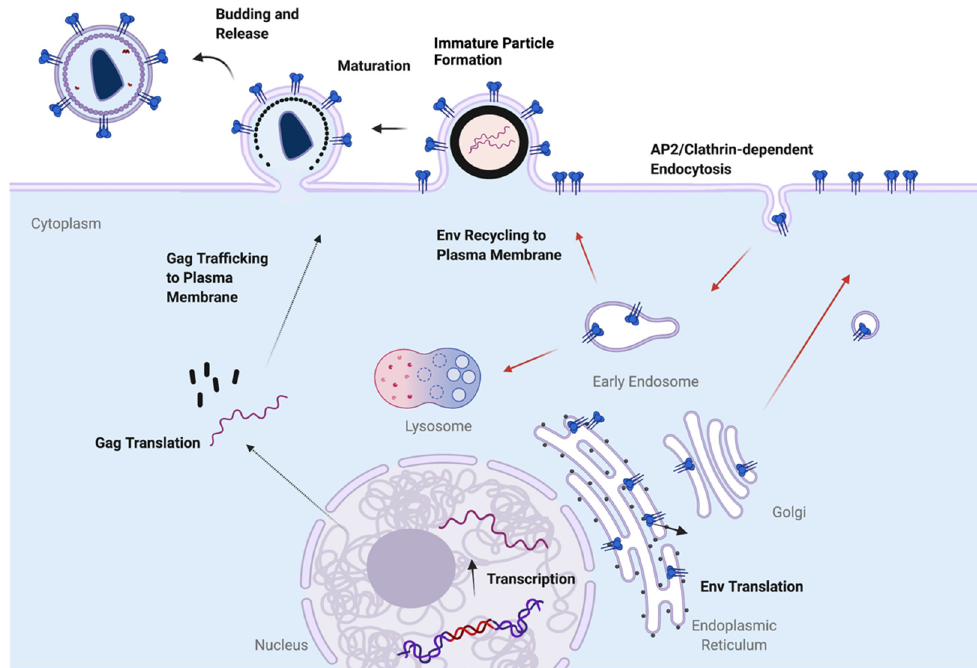
Figure 1. Overview of HIV-1 assembly process. Gag is translated on cytosolic ribosomes and trafficked to the PM. Env is synthesized on the rough ER and transits the secretory pathway to reach the PM. Following arrival at the PM, Env is rapidly endocytosed. Env may follow several routes after arriving in the early endosomal compartment, including proceeding to late endosomes and the lysosome for degradation, or recycling to the PM to pair up with Gag for incorporation into developing particles. Note that this is a simplified schematic, and thus does not indicate all possible pathways for Env trafficking.